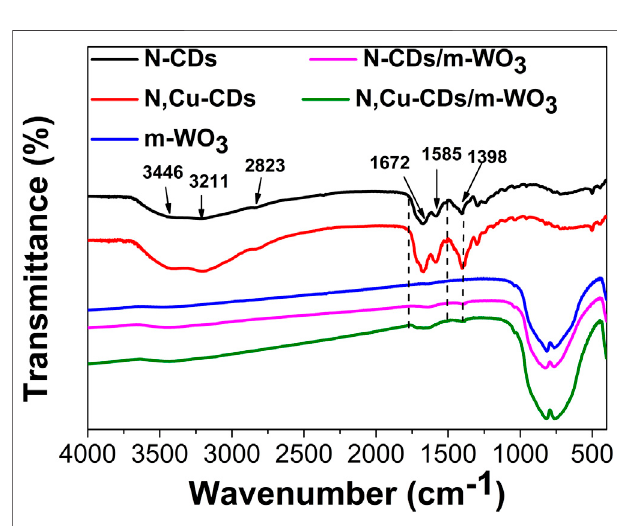
FIGURE 2 | The nitrogen adsorption − desorption isotherms of the as- synthesized samples. Inset depicts the BJH pore-size distributions.